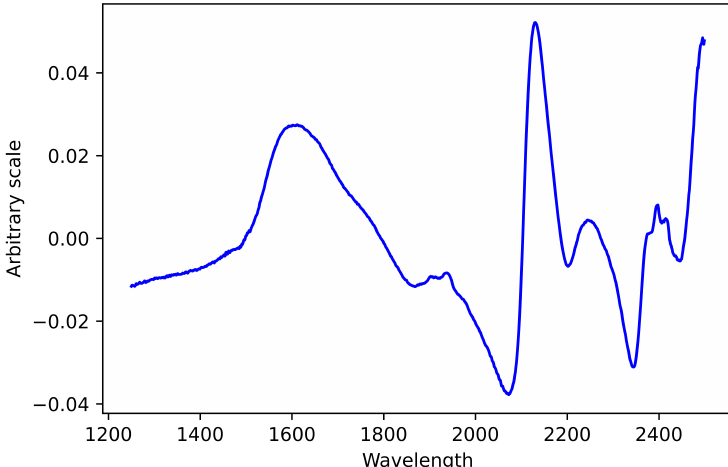
Figure 3. NIR pretreated spectrum.